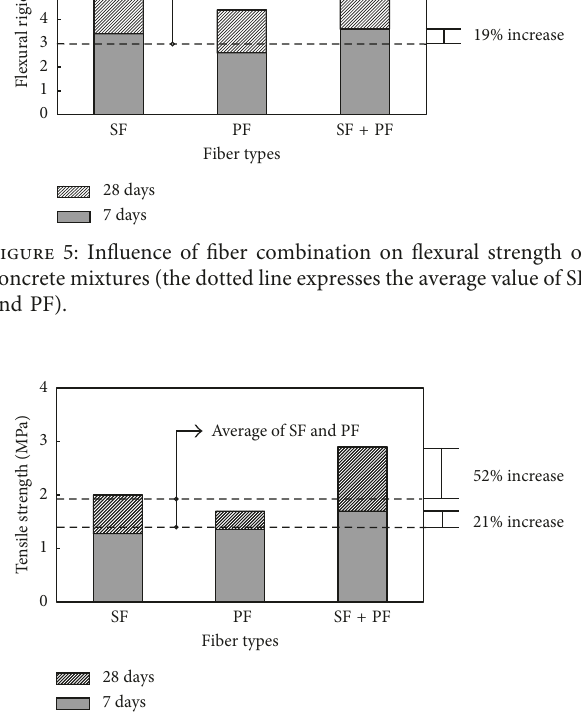
Figure 6: Influence of fiber combination on tensile strength of concrete mixtures (the dotted line expresses the average value of SF and PF).